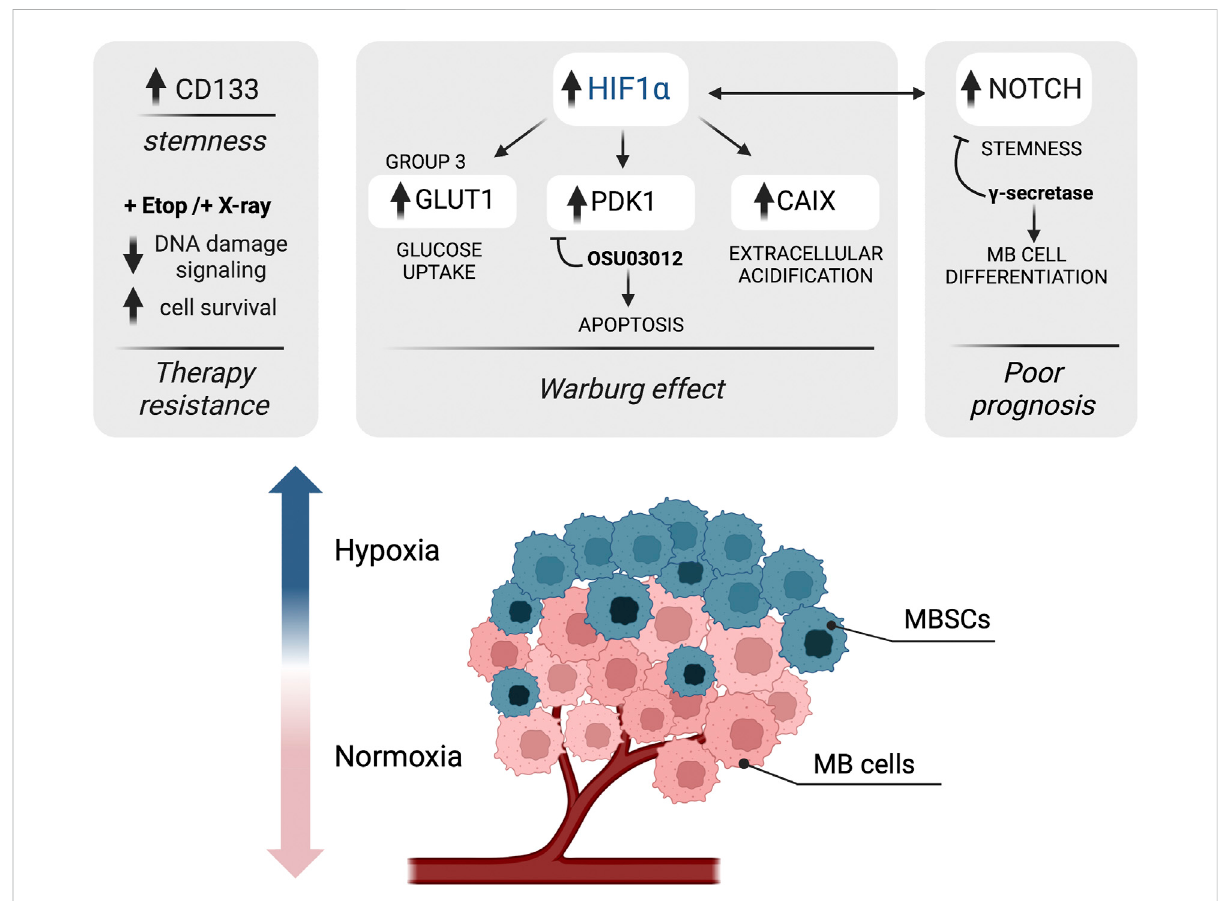
FIGURE 3 Schematic representation of the impact of hypoxia-associated metabolic adaptation in MB. Hypoxia is a major component of the tumor microenvironmentthatshapestumorheterogeneity;thelevelsofoxygenincancercellsdecreasewithincreasingdistancefromthebloodvessels.In hypoxic MB cells, hypoxia-inducible factor 1 alpha (HIF1 α ) supports the Warburg effect by upregulating the expression of genes involved in the glycolytic pathway, such as GLUT1, carbonic anhydrase IX (CAIX) and pyruvate dehydrogenase kinase 1 (PDK1). The use of PDK1 inhibitor OSU03012 induces mitochondrial-dependent apoptosis in MB. Moreover, hypoxic conditions were found to trigger upregulation of NOTCH, which correlates with a poor prognosis in MB. A connection between HIF1 α and NOTCH signaling is also found, driving stemness and cancer stem